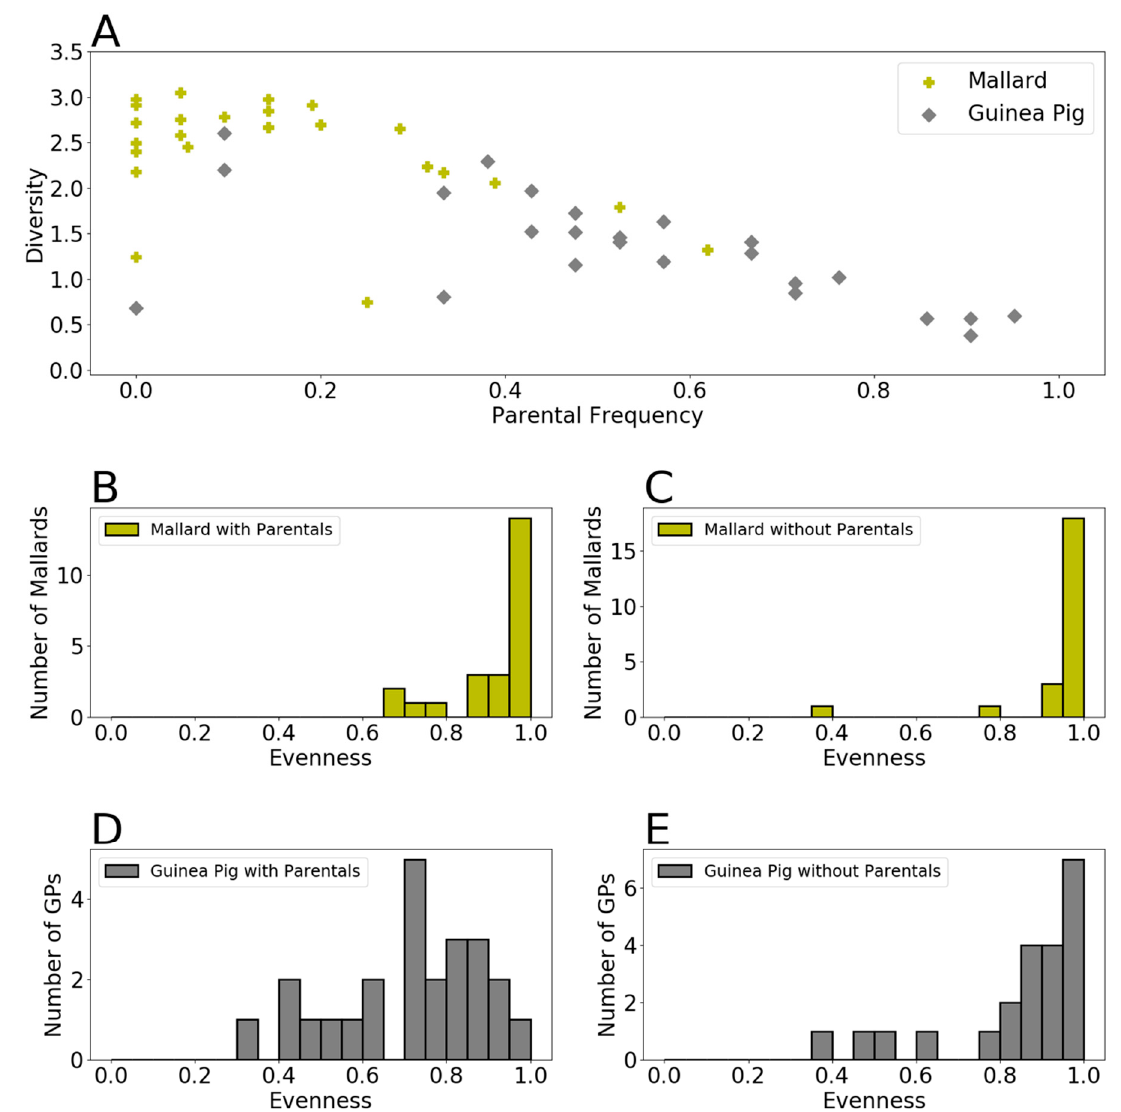
Figure 3. Lower levels of viral diversity in guinea pigs are only partially accounted for by high frequency of parental genotypes. ( A ) Scatter plot of Shannon-Weiner diversity against parental genotype frequency. ( B ) Histograms showing evenness of virus samples in mallards. ( C ) Histograms showing evenness of virus samples in mallards, following removal of parental genotypes. ( D ) Histograms showing evenness of virus samples in guinea pigs. ( E ) Histograms showing evenness of virus samples in guinea pigs, following removal of parental genotypes.